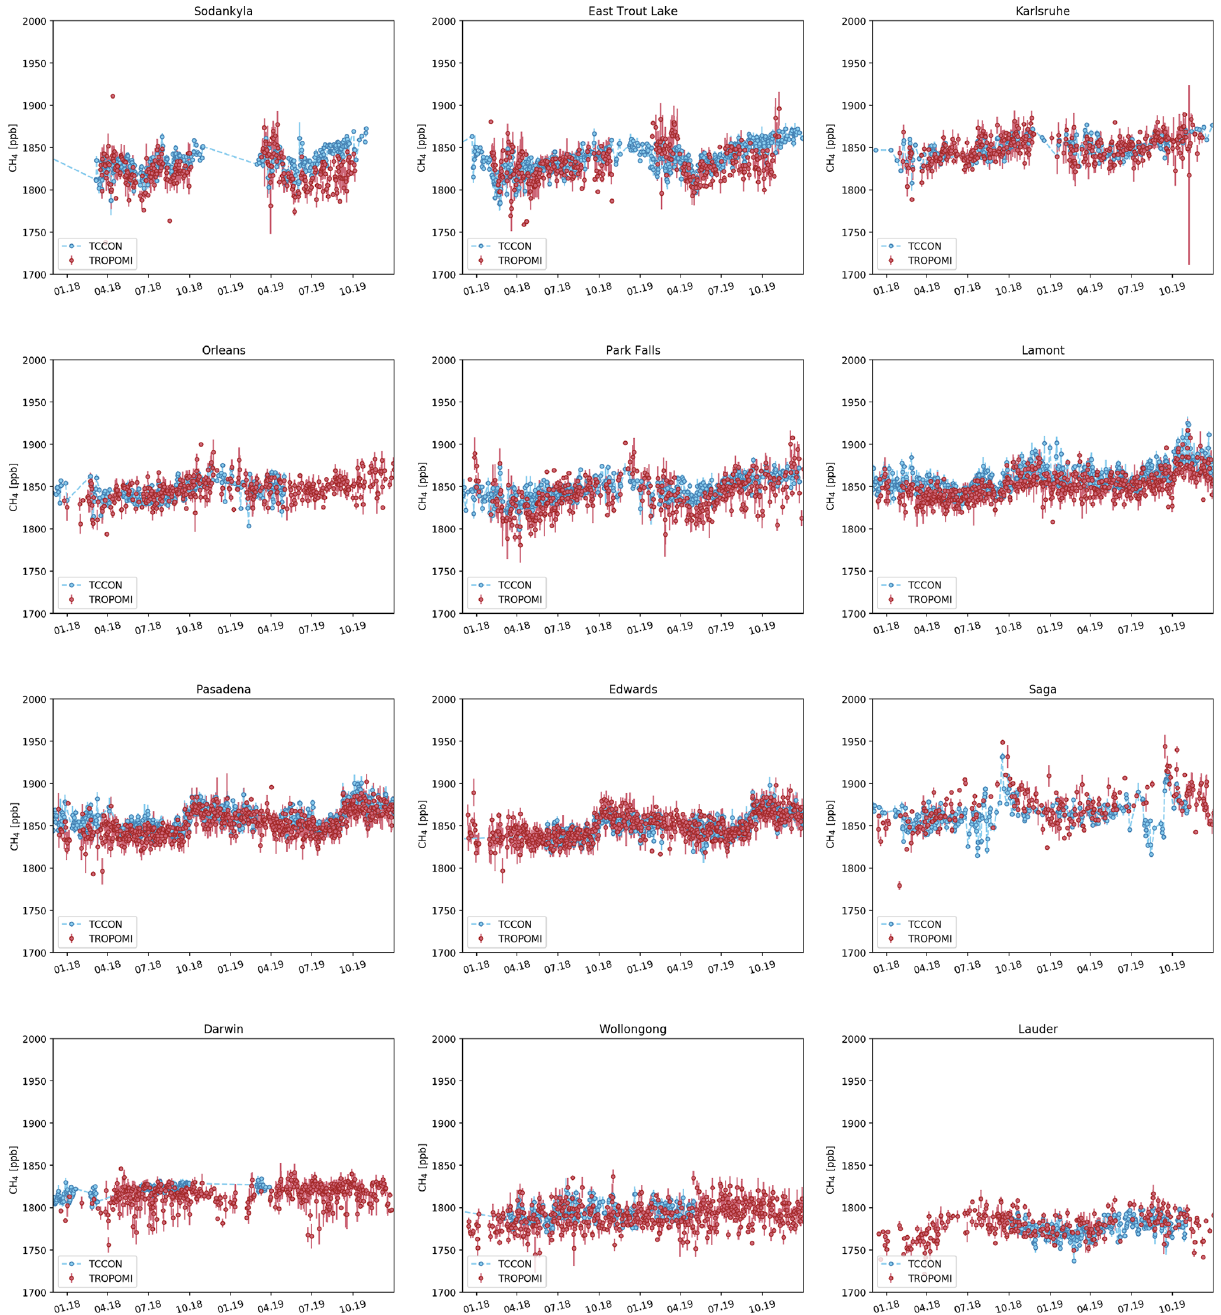
Figure 7. Time series of daily averaged XCH 4 measurements from TROPOMI (red) and TCCON (blue) over the selected stations for the period 1 December 2018–31 December 2019. TROPOMI measurements around a circle of 300km radius around each station have been selected for the